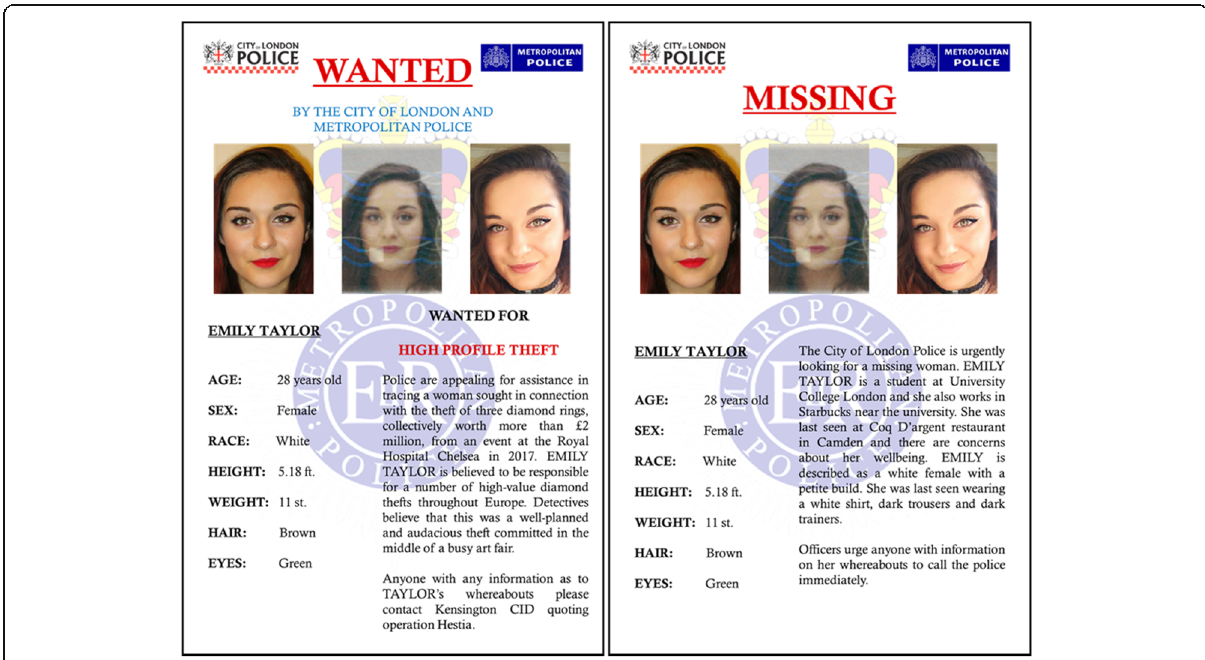
Fig. 7 Examples of wanted and missing posters used throughout study 4. Copyright restrictions prevent publication of the original target images. The target person shown here is a volunteer who has given permission for the images to be